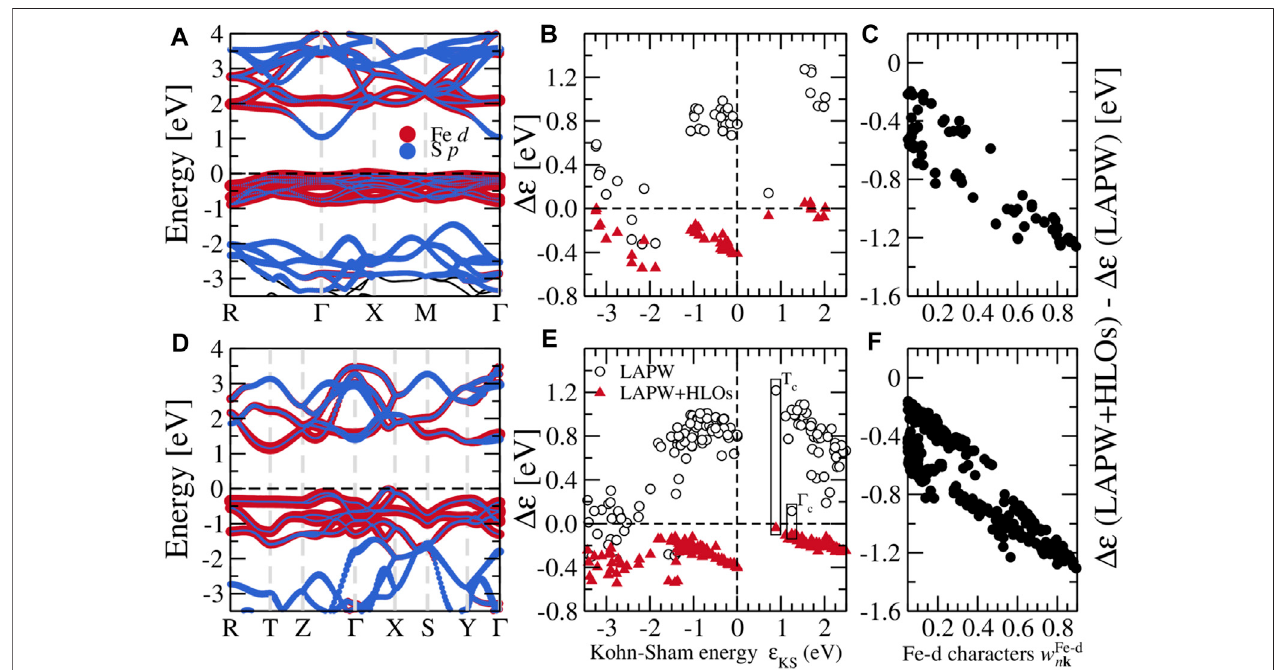
FIGURE 4 | (A) Projected band structure from GW with the LAPW + HLOs basis, (B) self-energy corrections Δ ε to Kohn-Sham states, and (C) the difference between Δ ε withLAPW+HLOsandLAPWbasisagainsttheweightofFe- d characters w Fe − d n k de fi nedby Eq.12 forpyriteFeS 2 . GW areperformedatthe G 0 W 0 level.The quasi-particle (A) and Kohn-Sham (B) energies are aligned to the corresponding valence band maximum. In (A) , projections of states on Fe- d and S- p orbitals are proportional to the diameters of red and blue circles, respectively. (D – F) are the counterparts for the marcasite